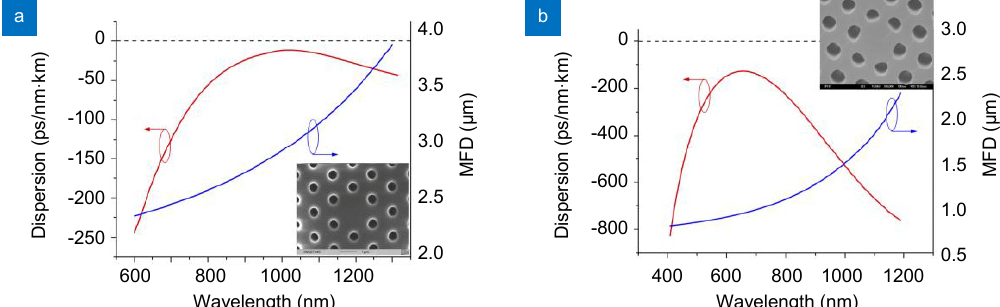
Fig. 3 | Measured dispersion curve and calculated mode field diameter (MFD) for PCF . ( a ) PCF A. ( b ) PCF B. Figure reproduced from ref. 20 , Optical Society of America.